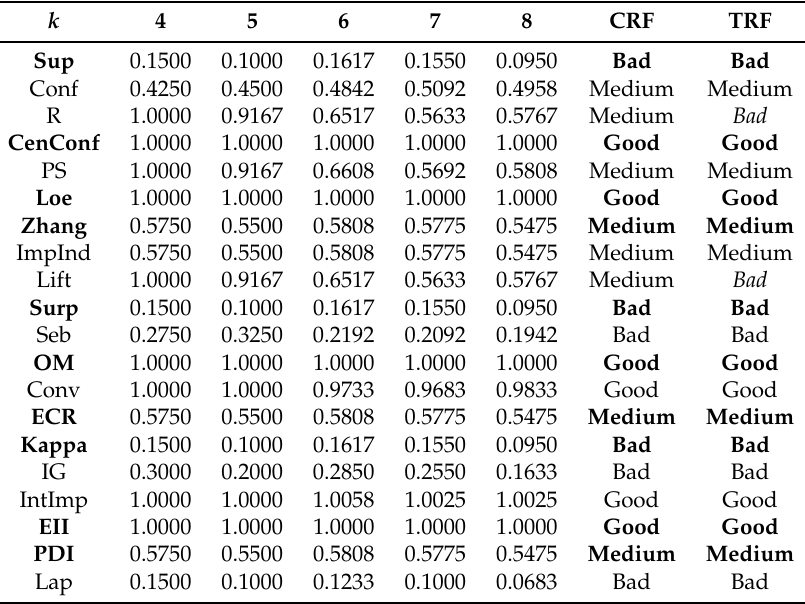
Table 7. The prediction results with k = 4 ∼ 8 and t =